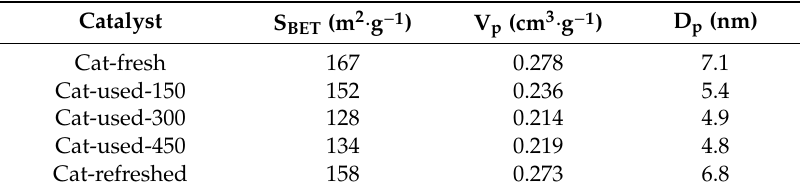
Table 2. Textural properties of